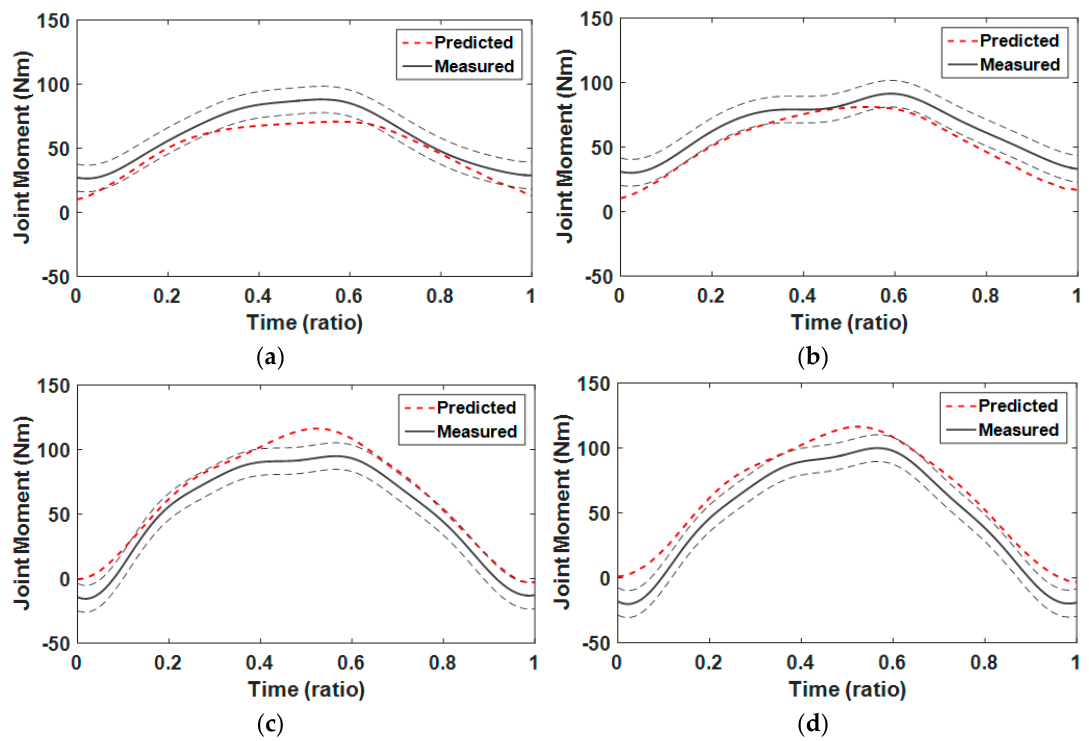
Figure 10. Comparison of moments of hip and knee joints for synthesized squat motion with those for average captured motion in the case where foot position was 0.07 h and guide angle was 5° from barbell bar center: ( a ) left hip moment; ( b ) right hip moment; ( c ) left knee moment; and ( d ) right knee moment.